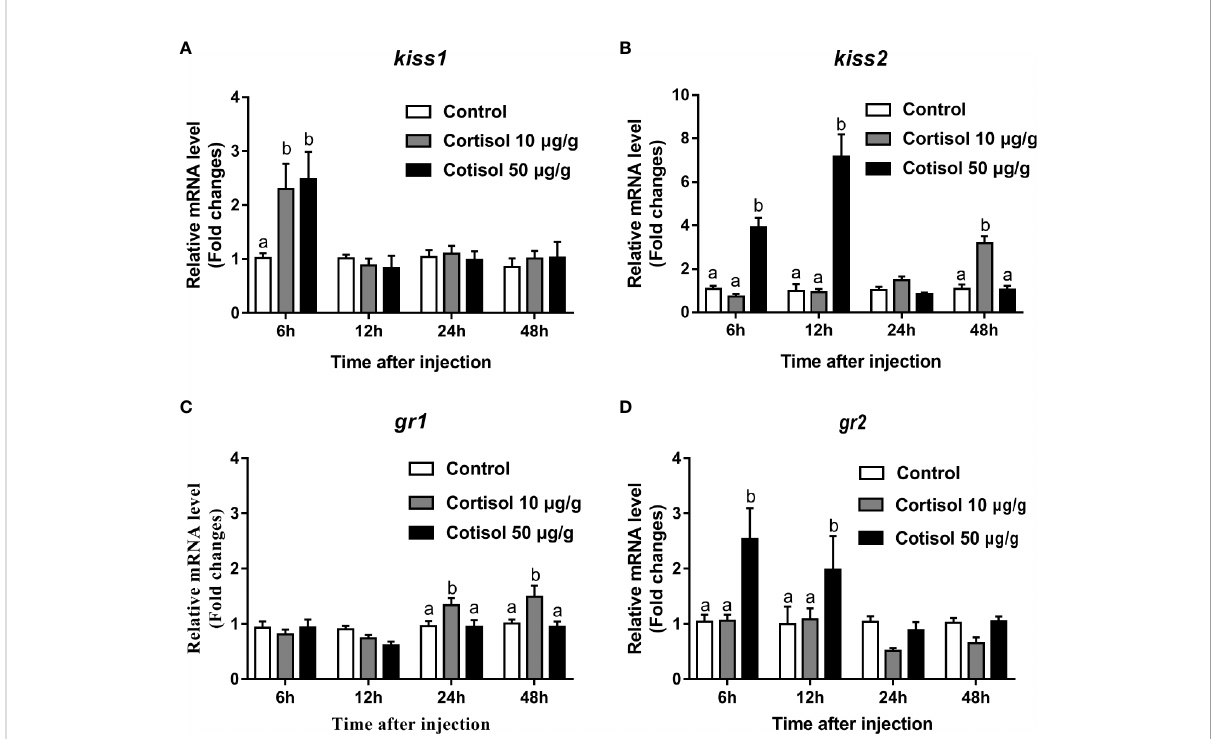
FIGURE 1 Effects of cortisol on kiss1 , kiss2 , gr1 , and gr2 mRNA levels in the brain of yellowtail clown fi sh. Expression of kiss1 (A) , kiss2 (B) , gr1 (C) , and gr2 (D) after injection of cortisol with both concentrations at 10 and 50 m g/g during 48 h. The data are expressed as mean ± SEM (n = 5 – 8). Bars with different letters indicate signi fi cant differences between treatments at the same sampling time (p <